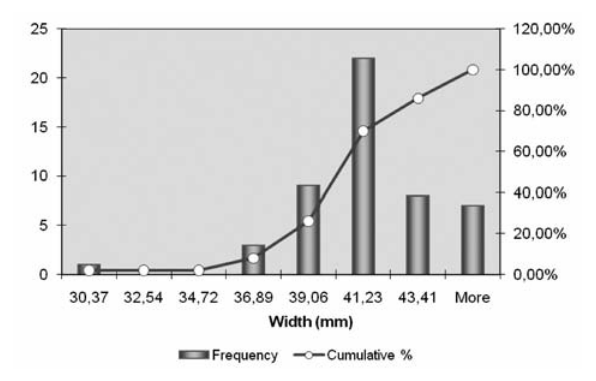
Fig. 26: Distribution of the width values of category B of Bergerouge